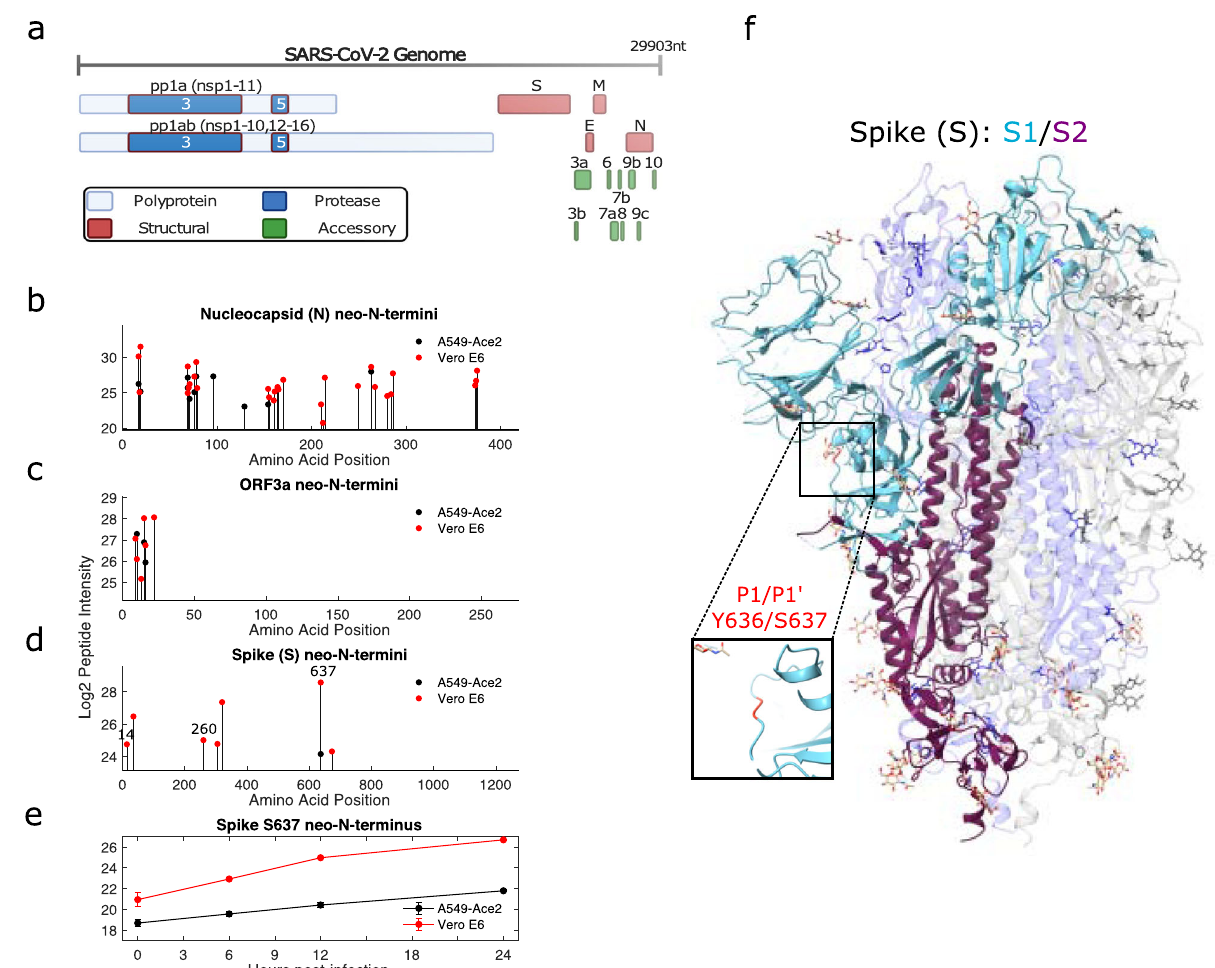
Fig. 2 Proteolysis of viral proteins during SARS-CoV-2 infection. a Schematic of the SARS-CoV-2 genome and proteome, with the nsp3 (PLP) and nsp5 (MPro) highlighted. Proteolytic processing of SARS-CoV-2 proteins during infection of A549-Ace2 and Vero E6 cells includes b extensive cleavage of the nucleocapsid protein, c N-terminal processing of the ORF3a putative viroporin, and d a novel cleavage site between Y636 and S637 in spike, N-terminal of the FURIN cleavage site. e The abundance of the S637 spike neo-N-terminus increases over the infection timecourse ( n = 3, error bars show standard deviation from 3 biological replicates). f This cleavage site is present on a fl exible region, C-terminal of the RBD (PDB: